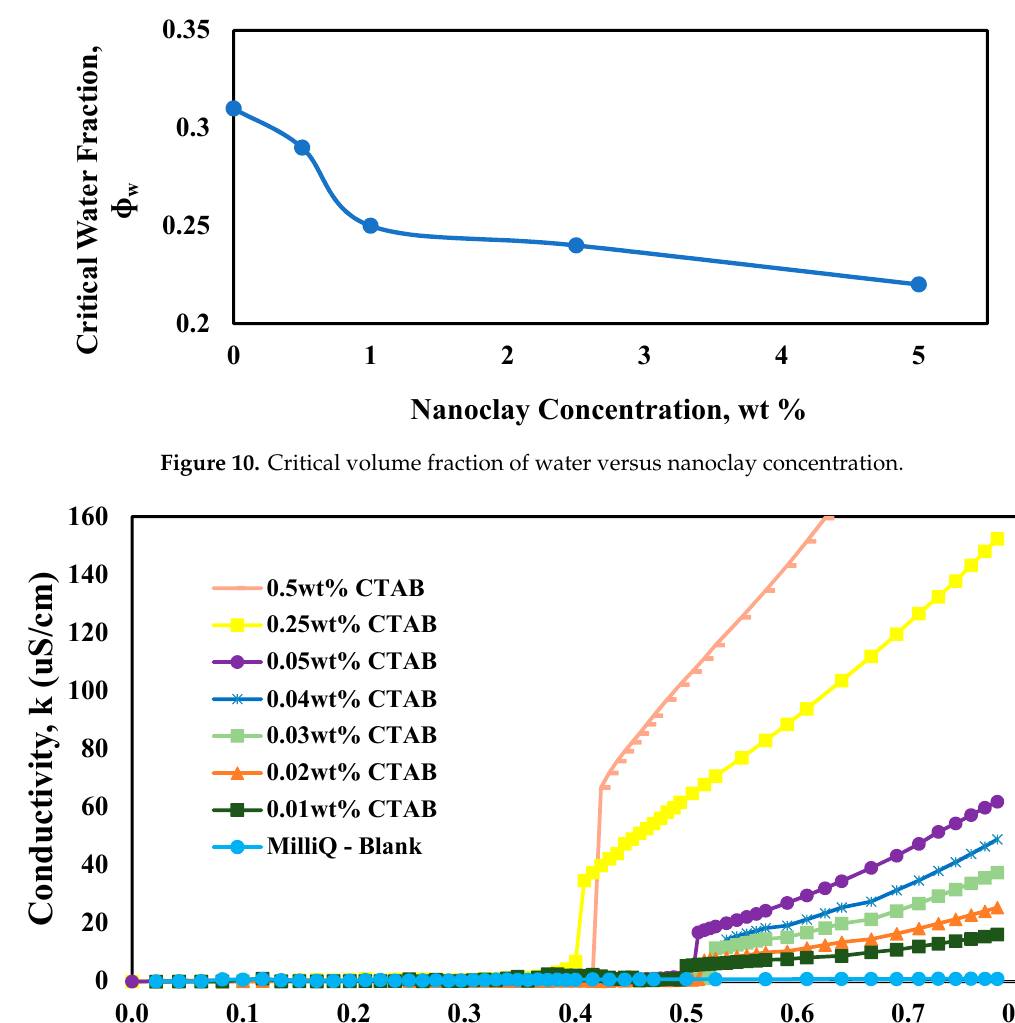
Figure 9. Conductivity of water–mineral oil emulsions stabilized by nanoclay solutions (0, 0.25, 0.5, 1, 1.75, 2.5, and 5 wt%) as a function of the volume fraction of water. Note: VF = volume fraction of water where phase inversion is observed.